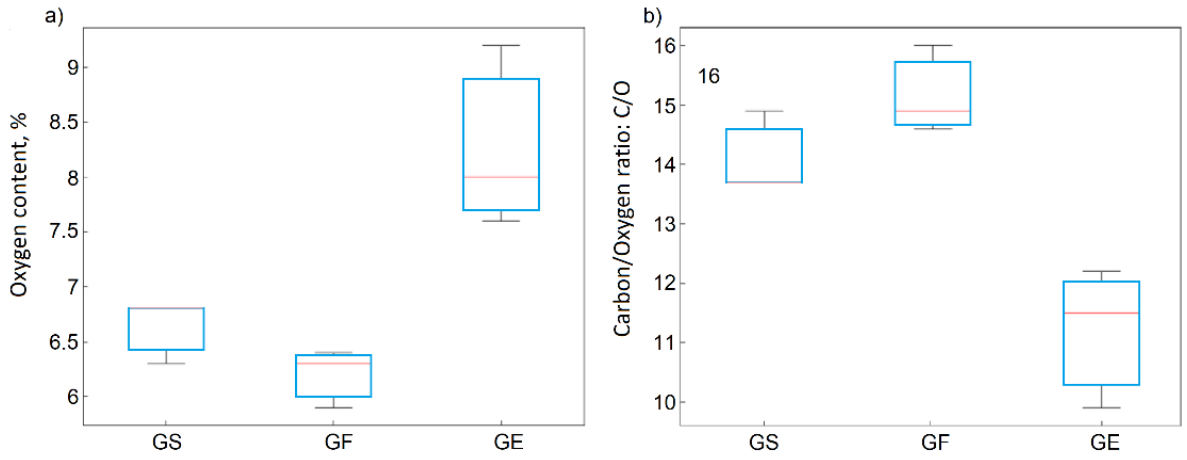
10 of 15 Figure 8. The clustered heat map for the studied GO and rGO samples and their properties. The oxygen contents determined by XPS ranged from 6.3% to 9.2% at and varied depending on the type of graphite in the following order: rGO-F < rGO-S < rGO-E. The